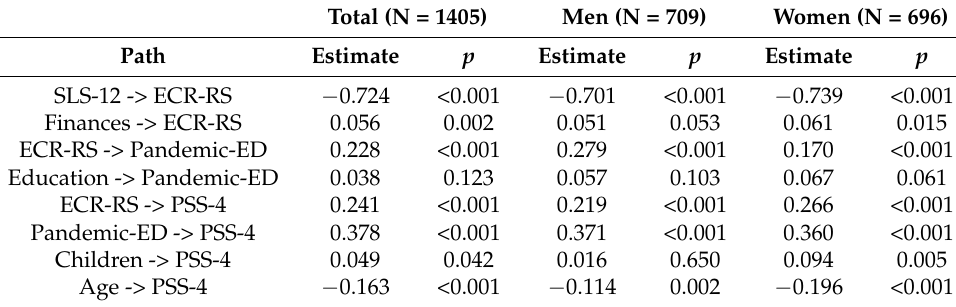
Table 8. Standardized regression weights for SEM